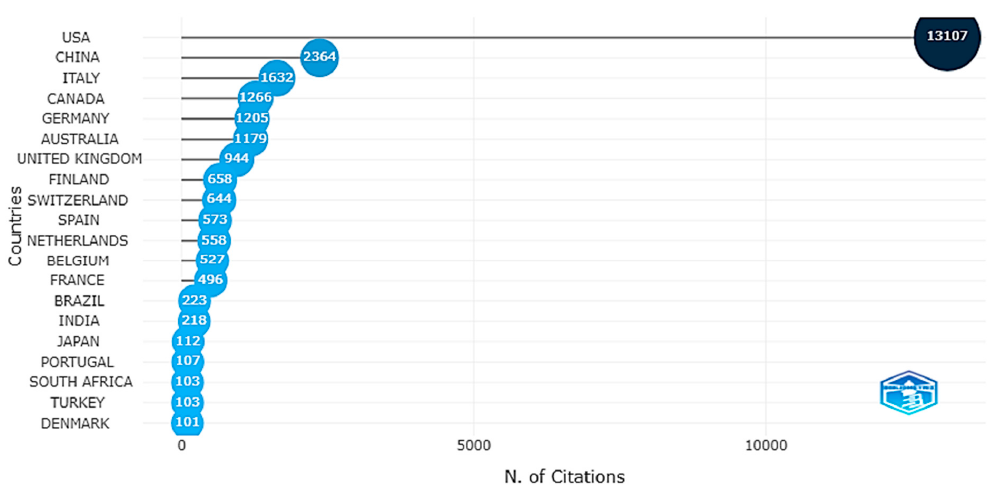
Figure 3. Most productive countries study on the fractional cover of forest algorithms.